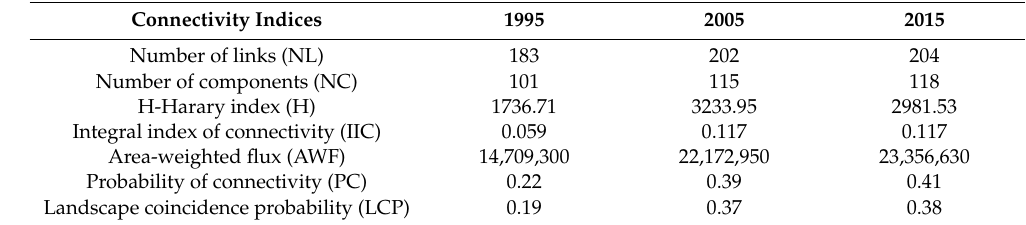
Table 5. Global landscape connectivity in di ff erent periods. NL , NC and H represent overall connectivity, IIC , AWF , PC and LCP represent probability